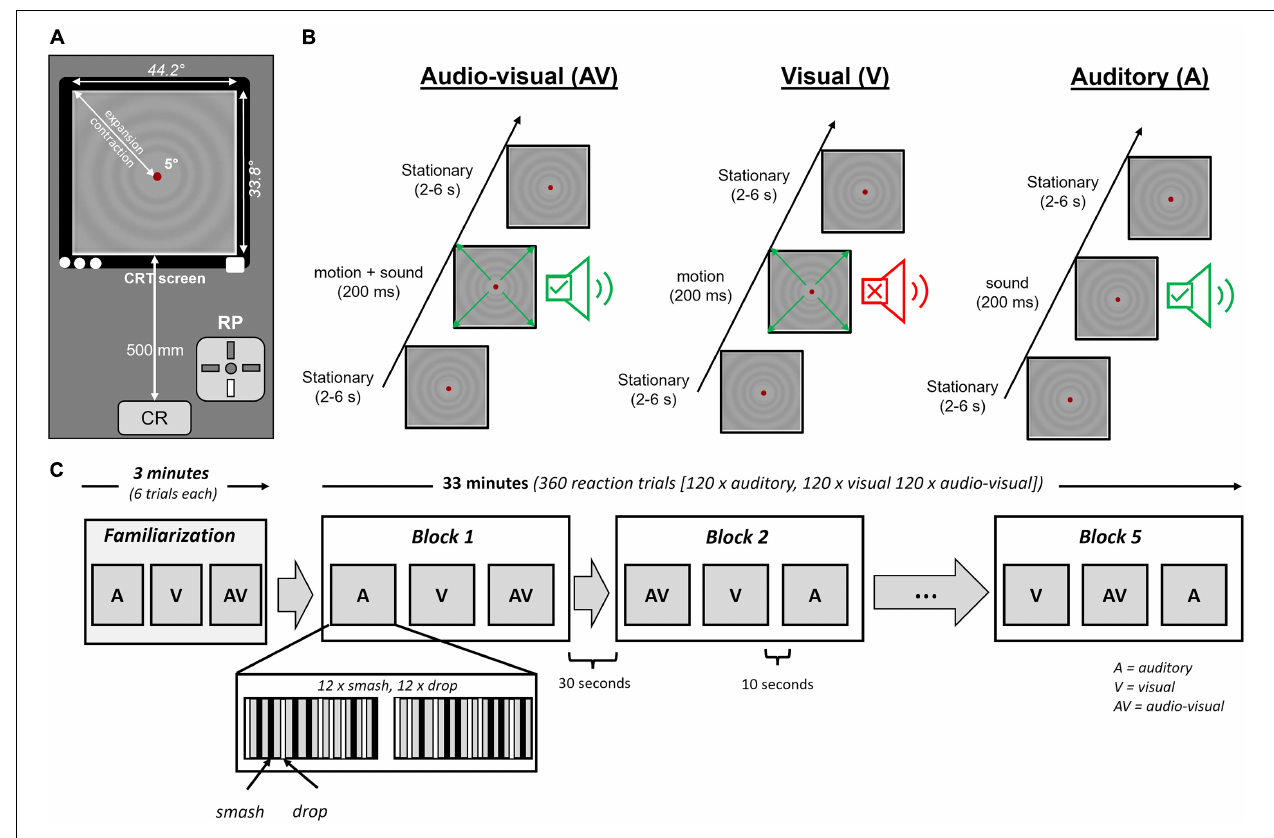
FIGURE 2 | (A) Experimental setup for the reaction test in front of the computer screen. Auditory stimuli were presented using insert earphones. (B) Organization of stimulation for the audio-visual (AV), visual (V), and auditory (A) condition. Stationary periods randomly varied between 2 and 6 s to avoid temporal anticipation of stimulus onset. (C) Overview of the protocol for the auditory (A), visual (V), and audio-visual (AV) stimuli.